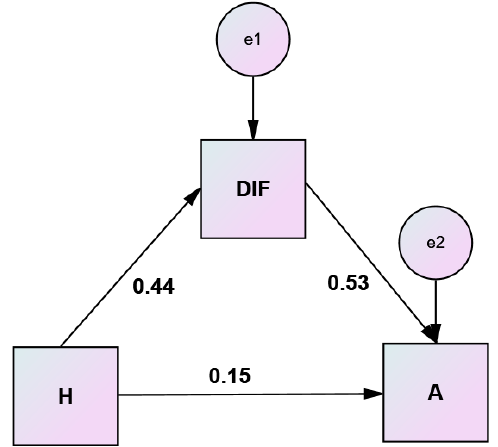
Figure 2. Simple mediation analysis of difficulty identifying feelings (DIF) on hostility (H)–anger (A) relationship.